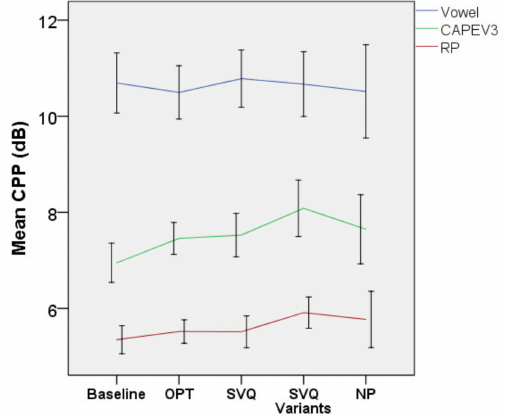
Figure 7. Cepstral peak prominence (CPP) of all vocal tasks. Error bars indicate 95% CI for the mean. Abbreviations: CAPEV3, third CAPEV phrase and RP, Rainbow